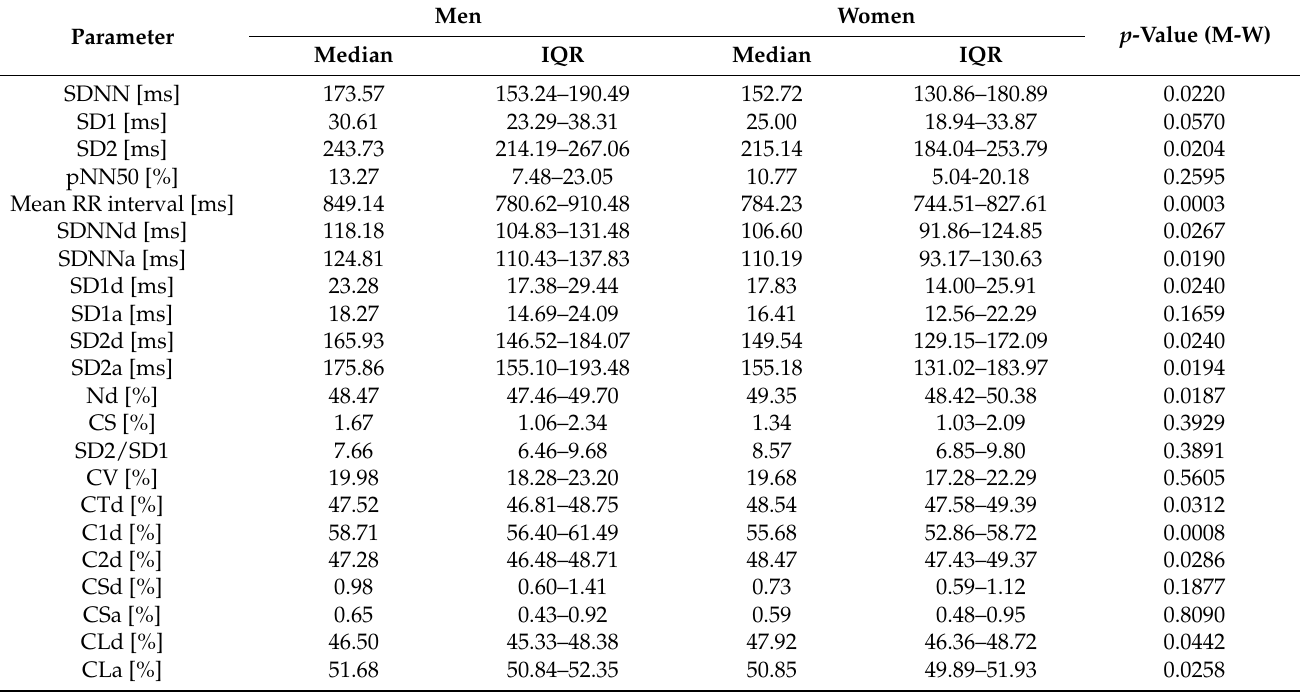
Table 3. HRV and HRA parameters for all studied men (n = 47) and women (n = 54) from 48-h ECG recordings of carefully selected healthy